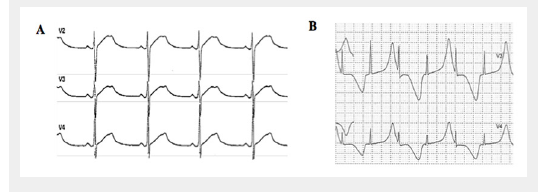
(A) Example of notched T waves from a 37-year old man affected by long QT syndrome (LQTS) who suffered two syncopal episodes. (B) Example of T wave alternans from a 2-year old LQTS patient with multiple episodes of cardiac arrest. Both tracings are from a 24-hour Holter recording. (Reproduced from reference